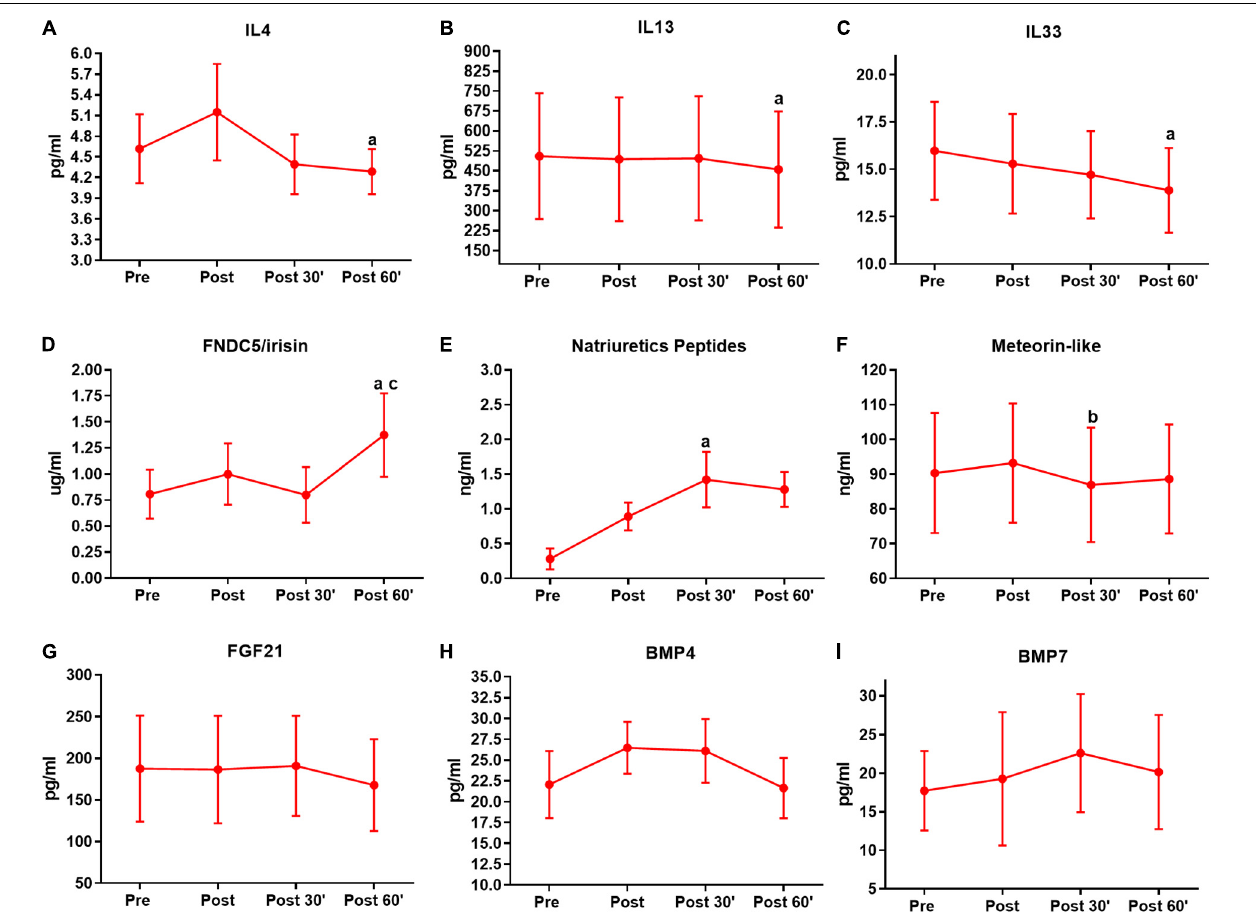
FIGURE 3 | Serum pro-thermogenic/anti-inflammatory inductors time-course in the first training session. (A) Interleukin 4 (IL4). (B) IL 13. (C) IL33. (D) FNDC5/irisin. (E) Natriuretic peptides. (F) Meteorin-like. (G) Fibroblast growth factor 21 (FGF21). (H) Bone morphogenic protein 4 (BMP4). (I) BMP7. a P < 0.05, difference from the moment pre. b P < 0.05, difference form the moment post. c P < 0.05, difference from the moment 30 (cid:48) . n = 15 per group, except FNDC5/irisin n = 8; and natriuretic peptides n = 12, both in feeding group. Values are in mean ± standard error.